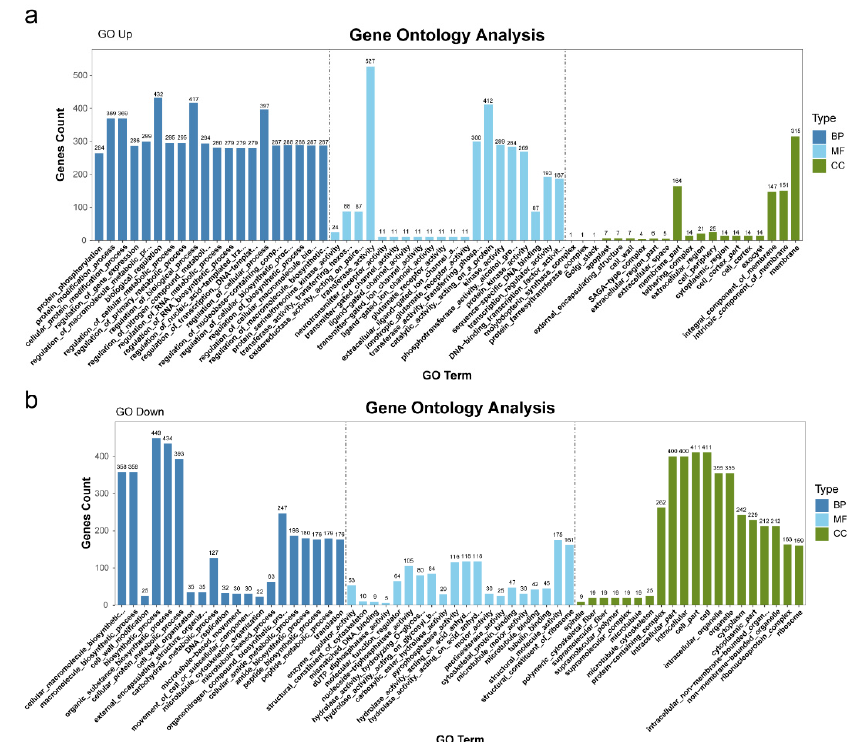
Figure 2. Functional classification of DEGs in eggplant roots under salt stress based on gene ontology (GO) analysis. GO analysis of up-regulated ( a ) and down-regulated ( b ) DEGs of the top 20 terms of biological processes (BP), molecular functions (MF), and cellular components (CC). Within biological processes, upregulated DEGs were significantly enriched in 127 pathways, including the response to oxygen ‐ containing compounds (GO:1901700) related to ABA responsiveness [46], the response to acid chemicals (GO:0001101) such as pyruvic acid, which is related to the process of ABA biosynthesis [47], and the response to water (GO:0009415) (Table S2). This indicated the role of ABA in plant responses to salt treat ‐